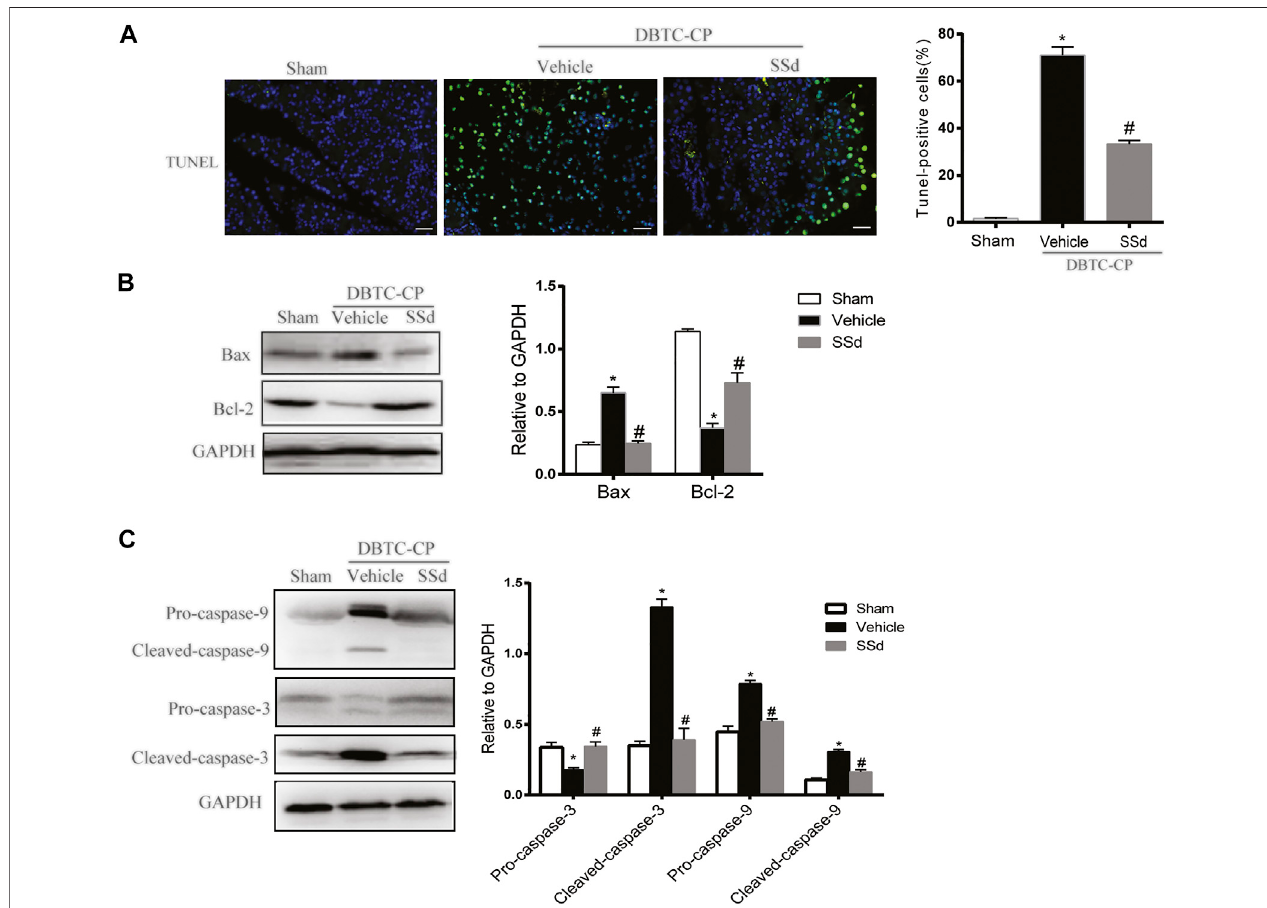
FIGURE 2 | SSd alleviates pancreatic injury in DBTC-induced CP. (A) Apoptosis of pancreatic cells were detected by TUNEL staining. (B) Western blot analysis of BAX, Bcl-2 in the pancreas. (C) Western blot analysis of apoptotic proteins Pro-caspase-3, Cleaved-caspase-3, Pro-caspase-9, and Cleaved-caspase-9 in the pancreas. Data are shown as the mean ± SEM of at least three independent experiments. ( n (cid:1) 6 – 8, p p < 0.05 vs. Sham group; # p < 0.05 vs. CP group).